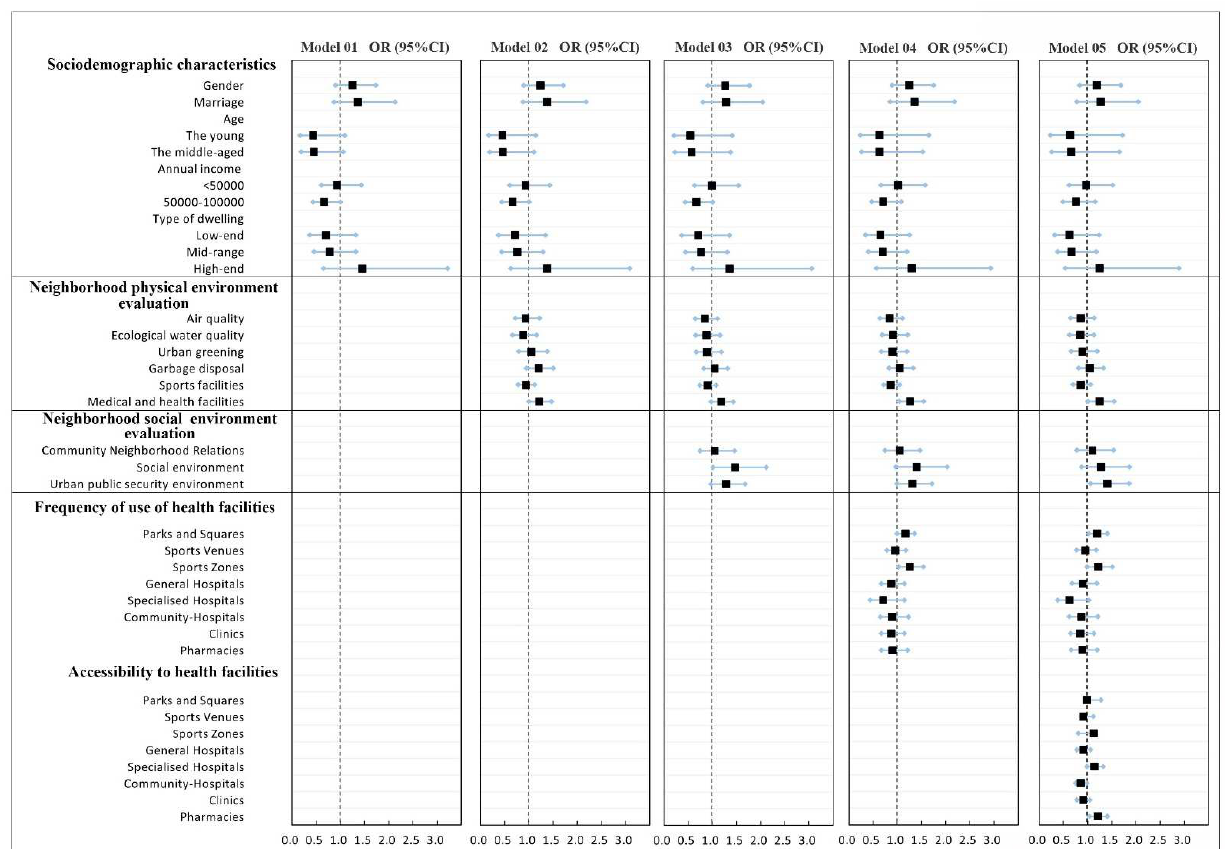
Figure 6. Ordered Logistic Regression Analysis of SRMH.